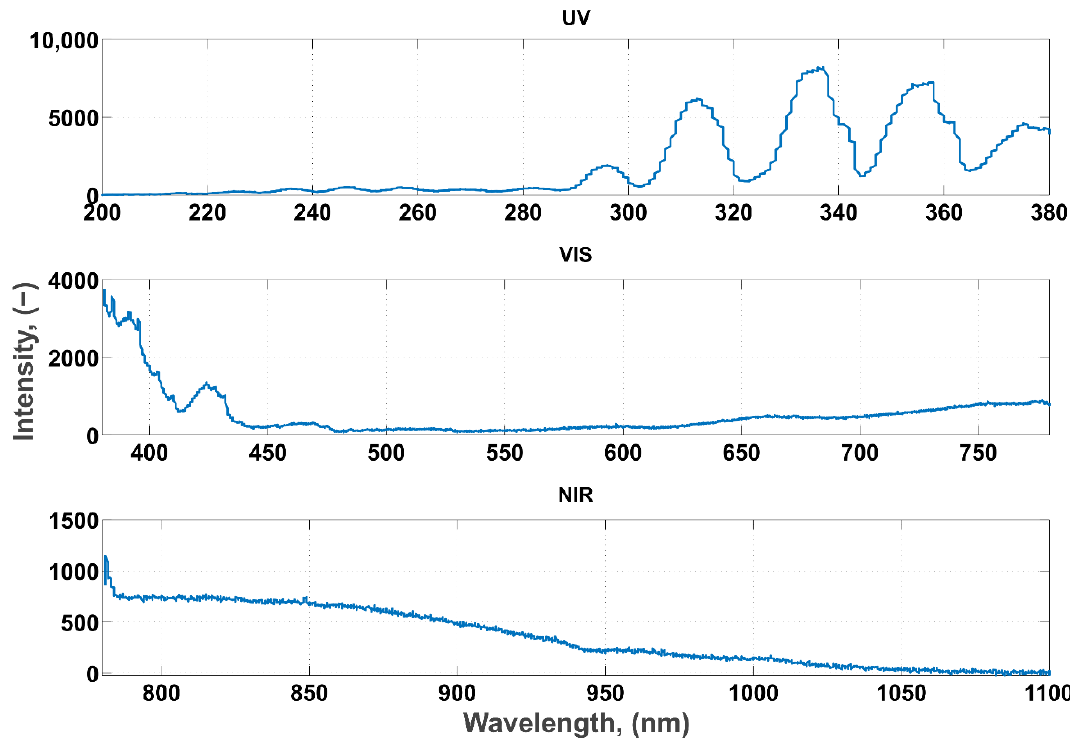
Figure 3. Example of the spectral distribution of the optical spectrum obtained for the electric arc.